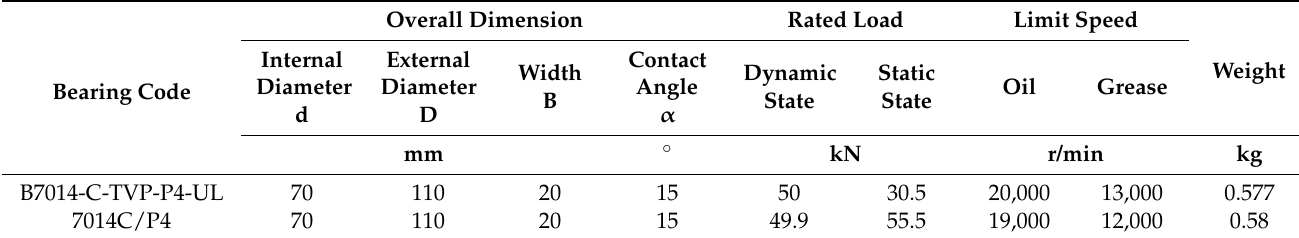
Table 2. Bearing parameter comparison.